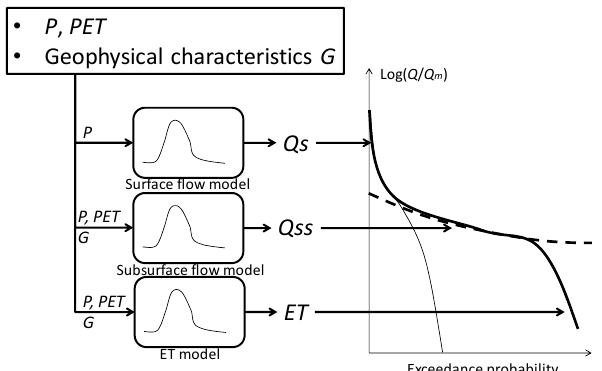
Fig. 8. A conceptual model for reconstruction of the flow duration curves in ungauged basins, consisting of models of (i) partition- ing of precipitation into fast (surface) runoff and wetting, which involves nonlinear (threshold filtering), (ii) the partitioning of the wetting into slow (subsurface) flow and evapotranspiration, which involves mainly linear filtering, and (iii) a correction to the FDC in flow situations due to evapotranspiration from saturated